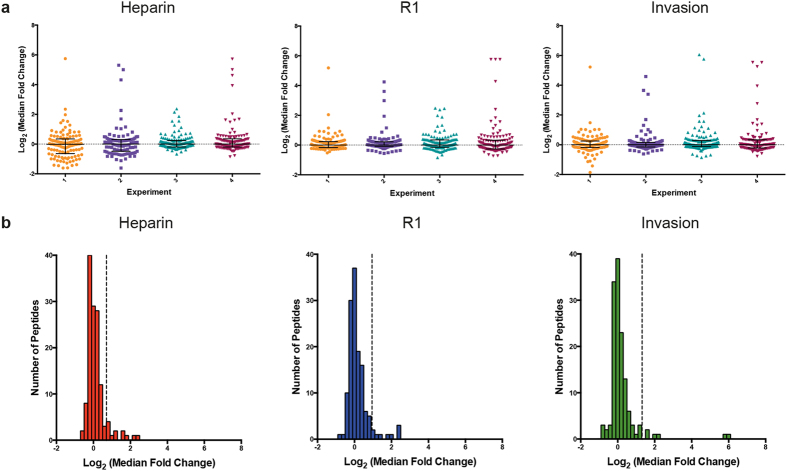
Quantitative phospho-proteomics of merozoite invasion.(a) Median fold-change values for high confidence phosphorylated and non-phosphorylated erythrocyte peptides were determined by comparing individual peptide abundances between test (containing added merozoites) and control (erythrocytes alone) samples. Data were transformed by median centering for the three conditions containing either heparin-based invasion inhibition, R1 mediated inhibition or invading merozoites. Bars represent the global median and inter-quartile range for each sample set. (b) Histograms from one invasion assay subjected to quantitative phospho-proteomics, displaying the transformed log2 (median fold change) value for each phosphorylated and non-phosphorylated erythrocyte peptide detected. Outlier minimums, produced using the ROUT method, are marked with the dashed line. Histogram bin width is 0.2.